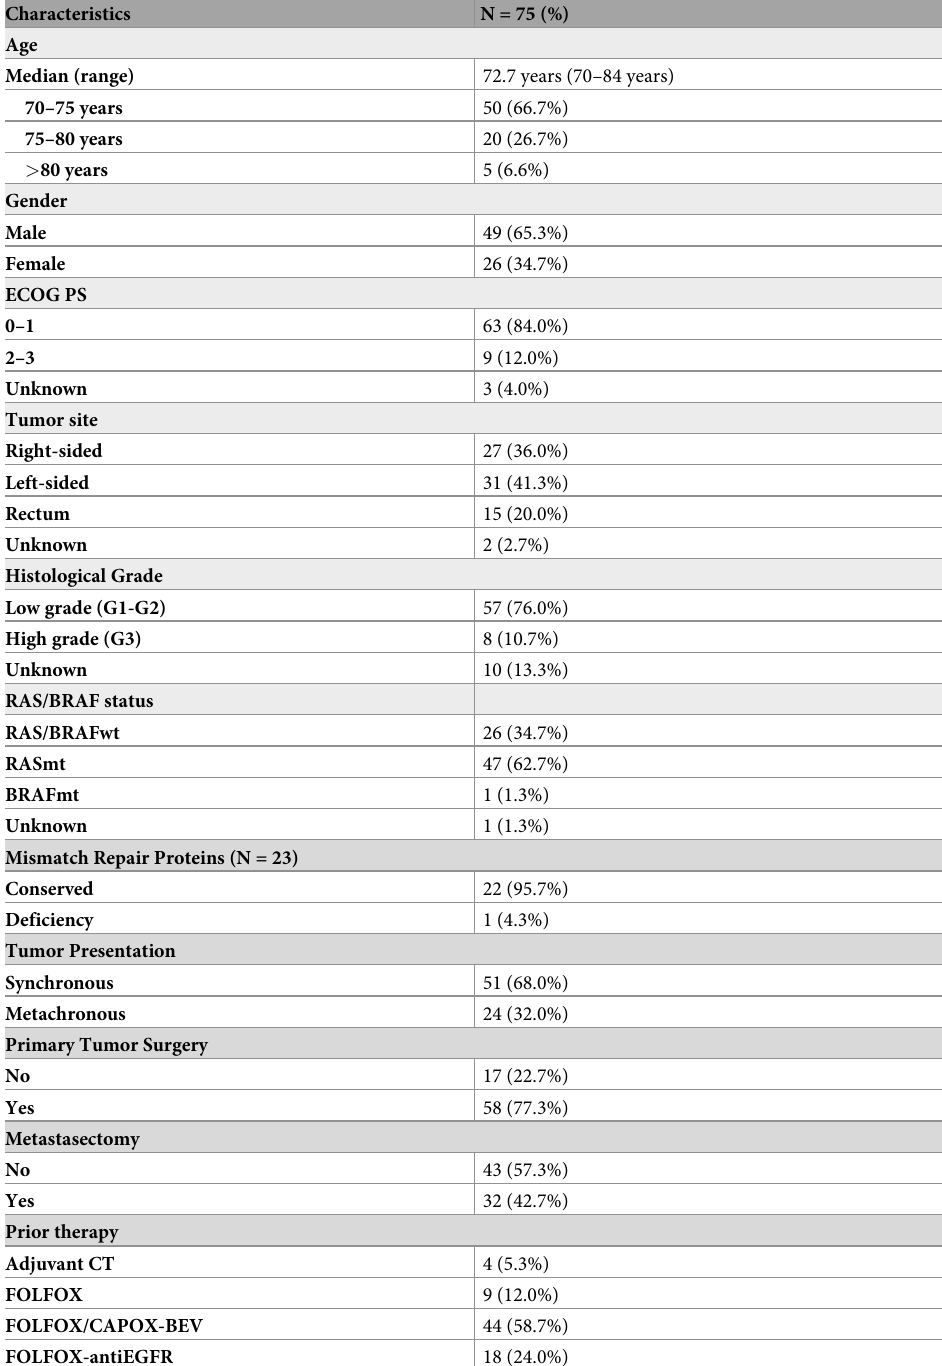
Table 1. Study population